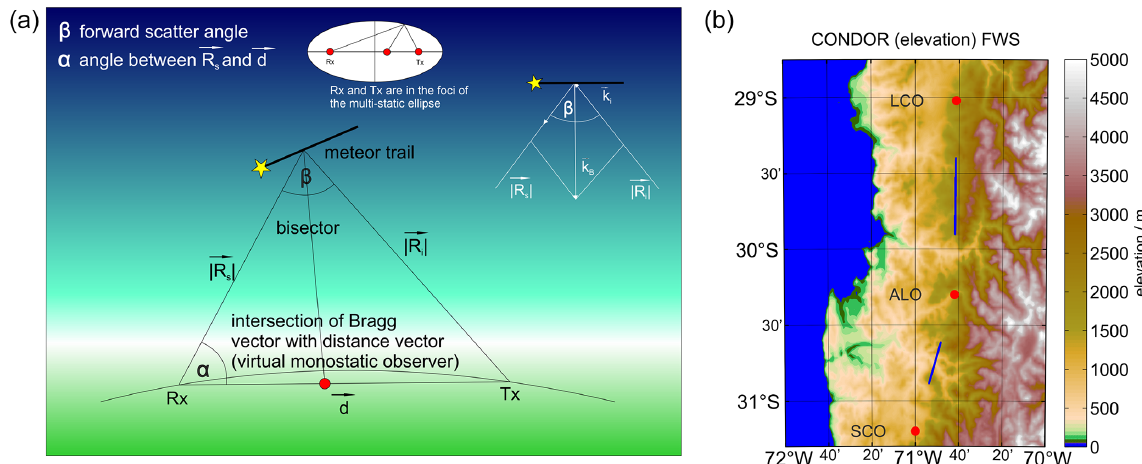
Figure 3. (a) Schematic representation of the forward scatter geometry and Bragg vector for CONDOR. (b) Geographic map of CONDOR with the active and passive radar locations at ALO, SCO and LCO (red dots). The two sets of intersection points of the Bragg vectors with the distance vector between Rx and Tx are shown as blue dots, which are only visible as two blue streaks due to the close proximity of the intersection